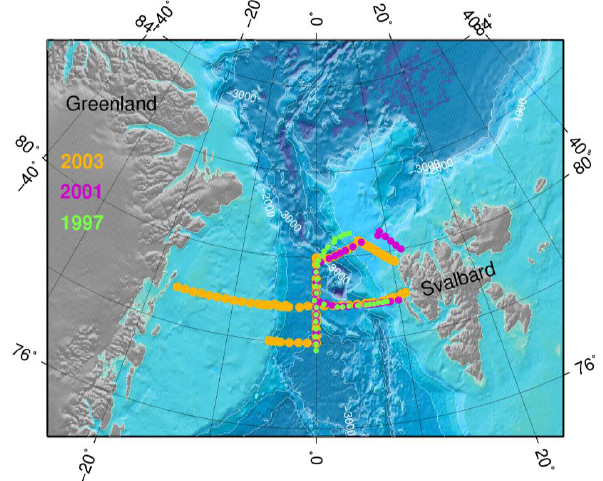
Fig. 4. Fram Strait bathymetry with 1997, 2001 and 2003 stations. Fig. 4 Map produced with GMT (Wessel and Smith, 1998).